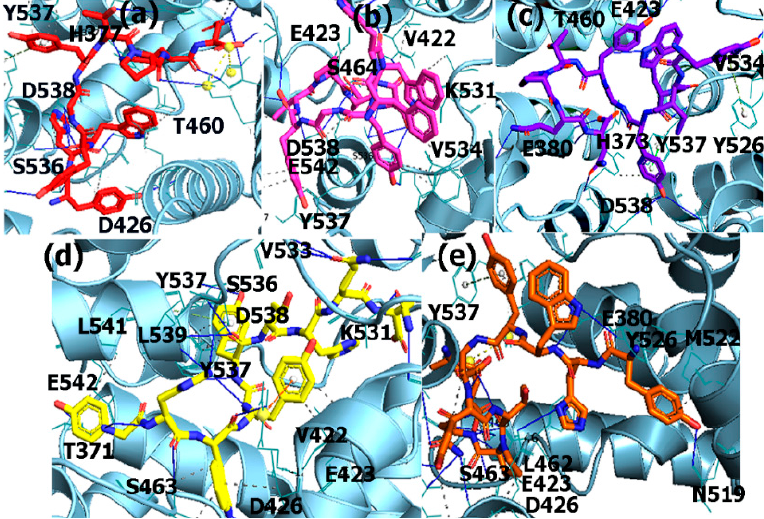
Figure 2. PLIP results with ER- α for ( a ) Pep; ( b ) Mut1 ( c ) Mut2 ( d ) Mut3 ( e ) Mut4.